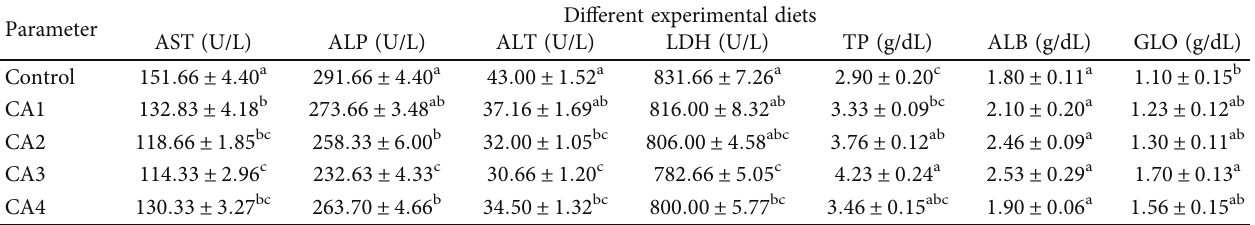
Data in a column assigned with di ff erent letters signify signi fi cant di ff erence between treatments ( P < 0 : 05 ). Values are presented as mean ± SE . AST: aspartate transaminase; ALP: alkaline phosphatase; ALT: alanine aminotransferase; LDH: lactate dehydrogenase; TP: total protein; ALB: albumin; GLO: globulin.